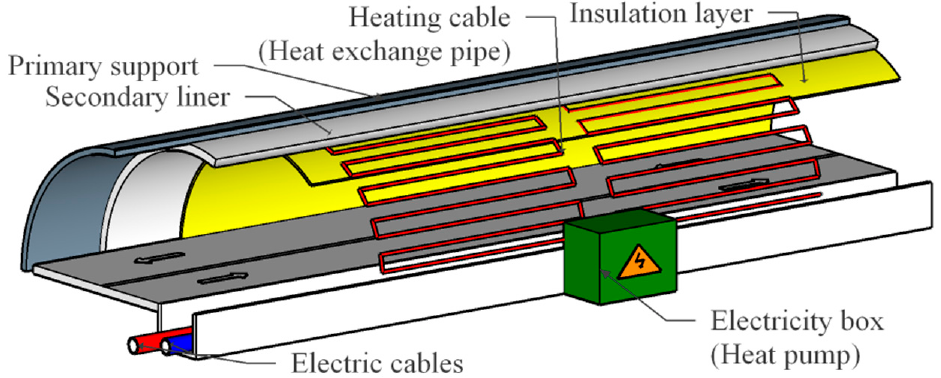
Figure 4. Heating system using electricity and geothermal energy [77,79].